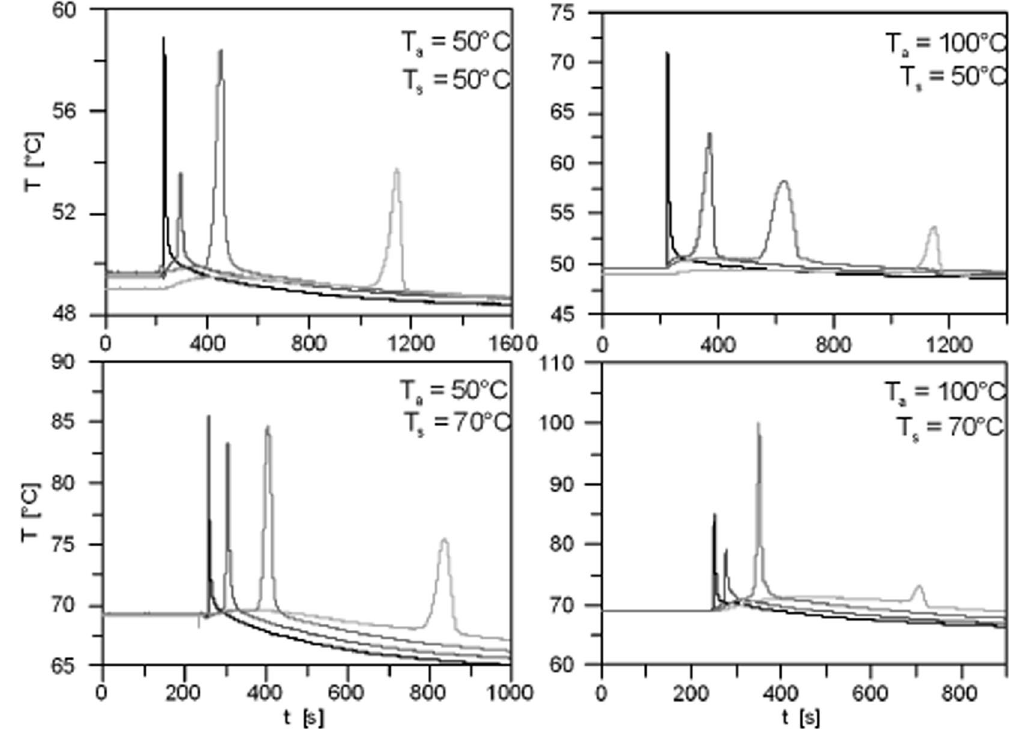
Figure 11. Temperature as a function of time in experiments of zoldak- Nowak et al . 12 . Two diagrams in the right were done on Zeolite pickings treated in 100 °C and ambient temperature 50 and 70 °C. Diagrams in left, Zeolite treatment in 50 °C and ambient temperature 50 and 70